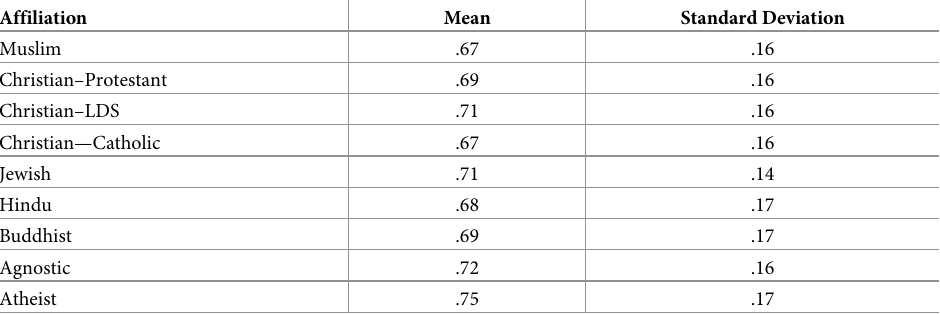
Table 3. The mean and standard deviation of evolution understanding scores disaggregated by religious affiliation.